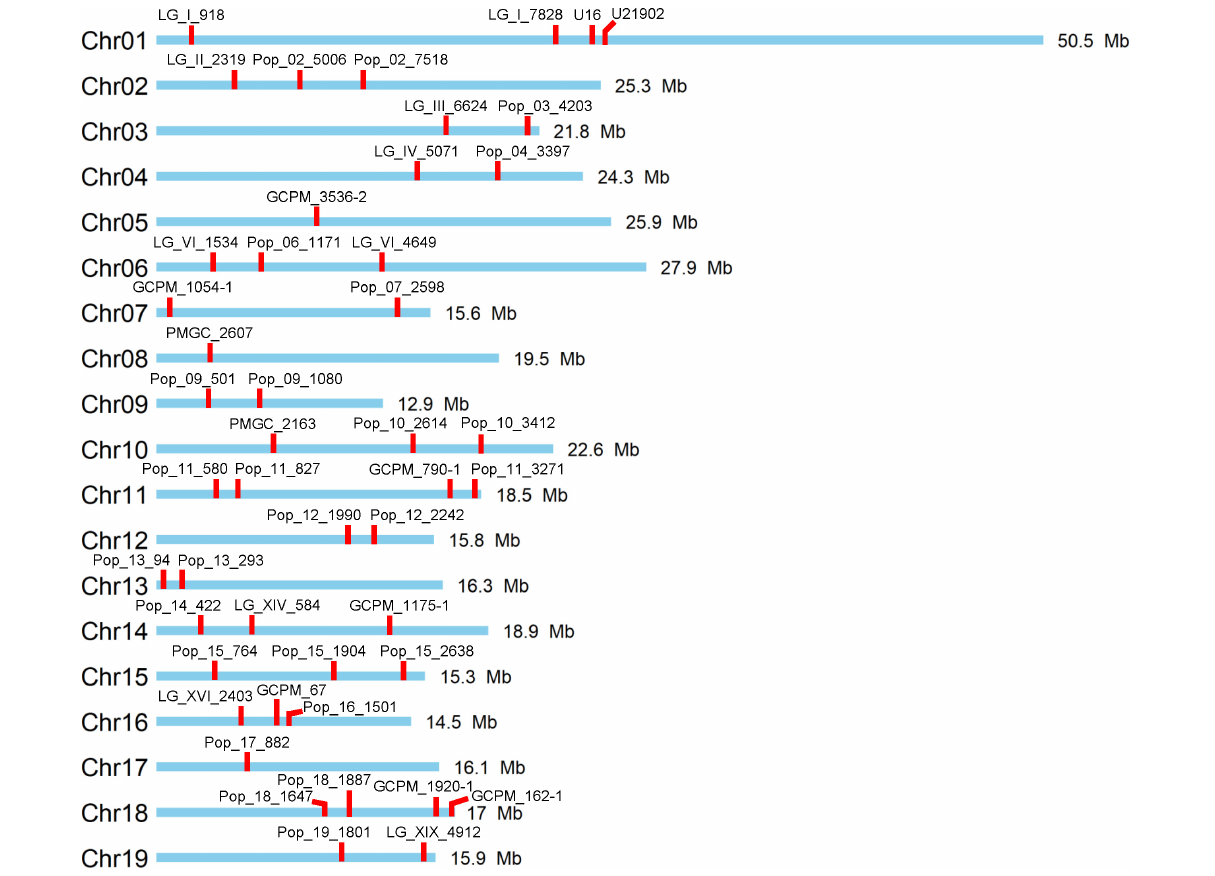
Frontiers in Plant Science |